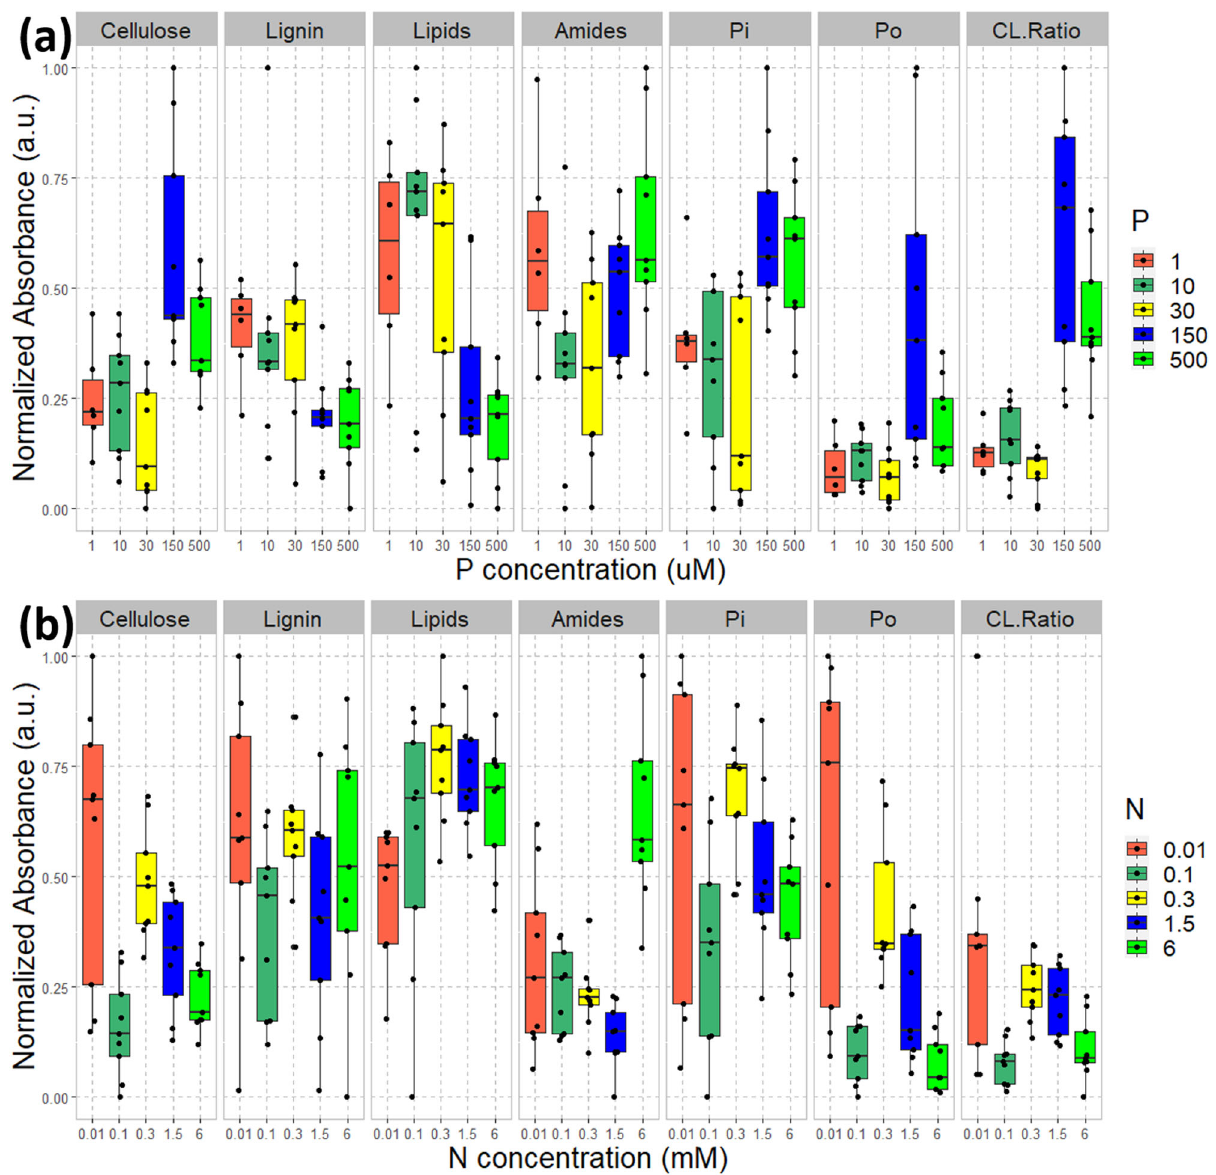
Fig. 1 Biochemical components of leaf tissue. Relationships between the normalized concentration (presented here as normalized absorbance at corresponding infrared frequencies) of biochemical components (cellulose, lignin, lipids, amides and inorganic/organic phosphates) in the leaf tissue samples of switchgrass plants and the concentration of a P- and b N- in the growth media of laboratory hydroponic experiments. “ CL.Ratio ” stands for the cellulose:lignin